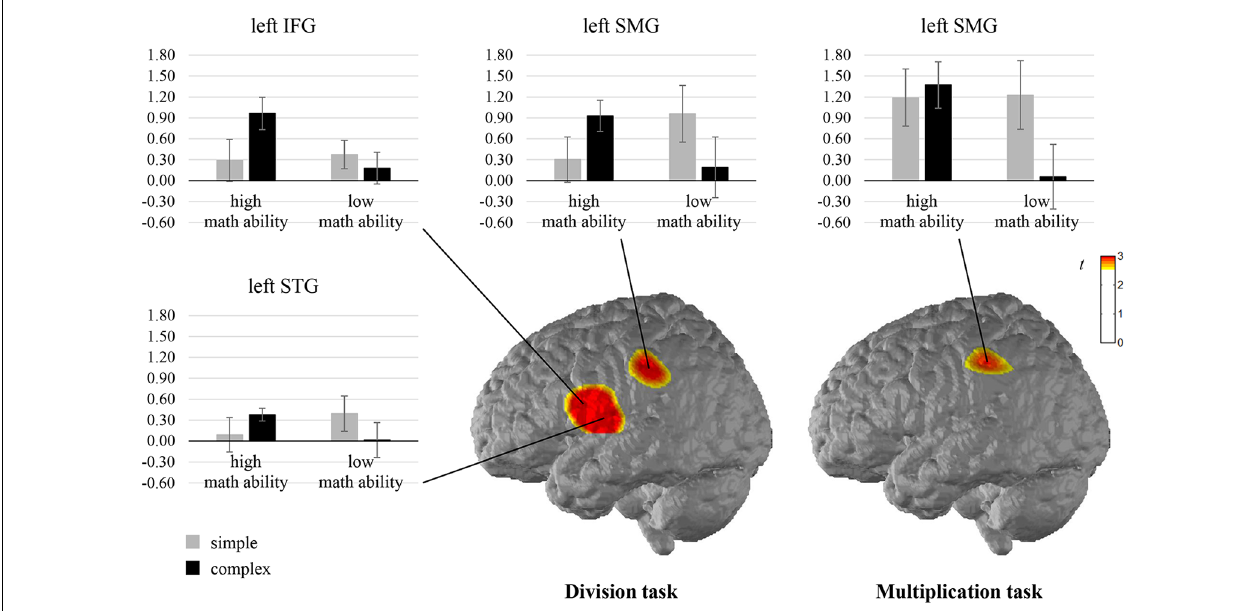
FIGURE 4 | T maps for the fNIRS data depicting differences in neural activation between individuals with high and low math ability in the complexity effect in the multiplication and division tasks. Abbreviations: IFG, inferior frontal gyrus; STG, superior temporal gyrus; SMG, supramarginal